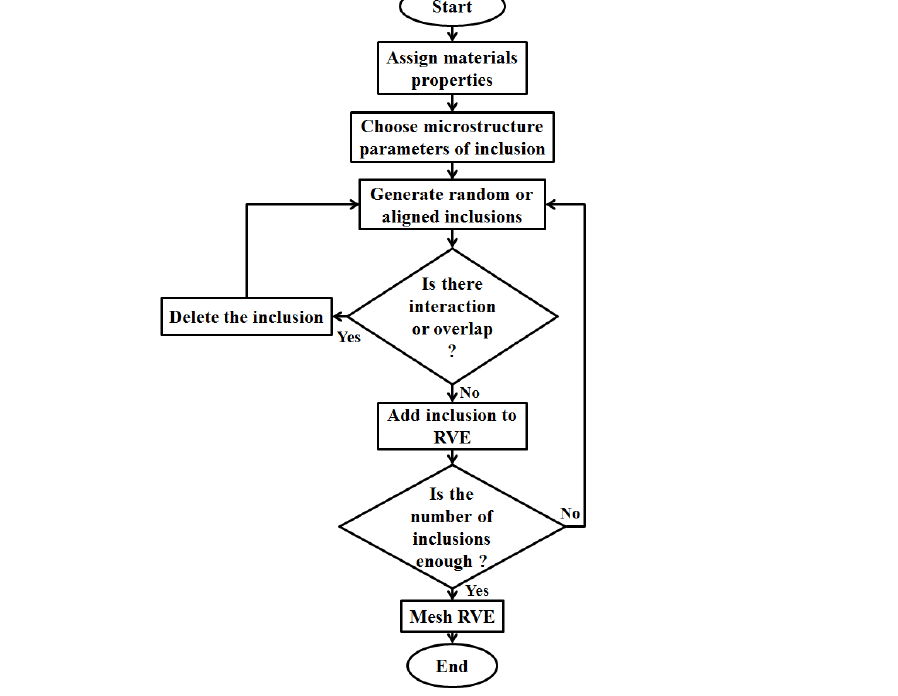
J. Compos. Sci. 2021 , 5 , x FOR PEER REVIEW Figure 4. RVE generation flowchart. Figure 4. RVE generation flowchart. Table 1. Mechanical properties of nanofillers, polymers and fibers.